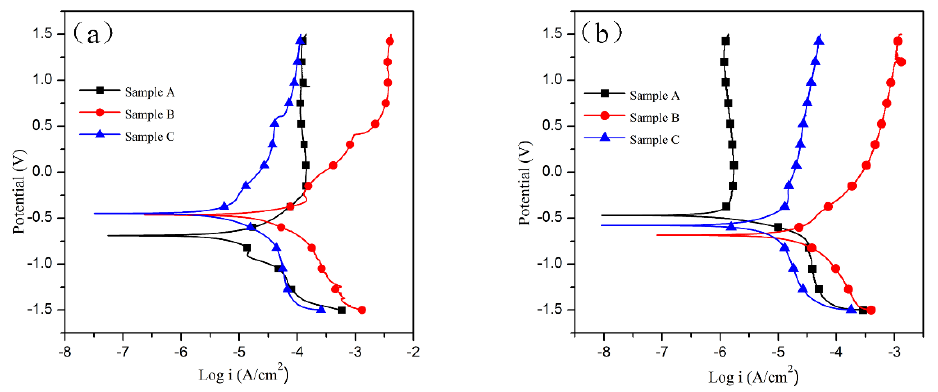
Figure 6. Potentiodynamic curves of SLM-produced Ti-6Al-4V samples with di ff erent build orientations: cross section ( a ) and longitudinal section ( b ). Table 3. Electrochemical parameters, i corr and E corr , obtained from the potentiodynamic polarization curves for the cross section and longitudinal section of SLM-produced Ti-6Al-4V samples with di ff erent build orientations